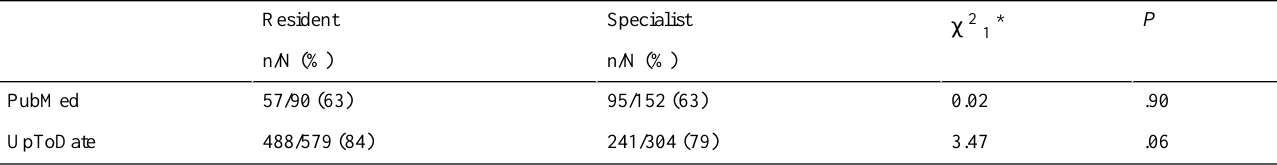
Table 4. Number and percentage of partial or full answers found by specialists and residents to questions sent to only one of the two